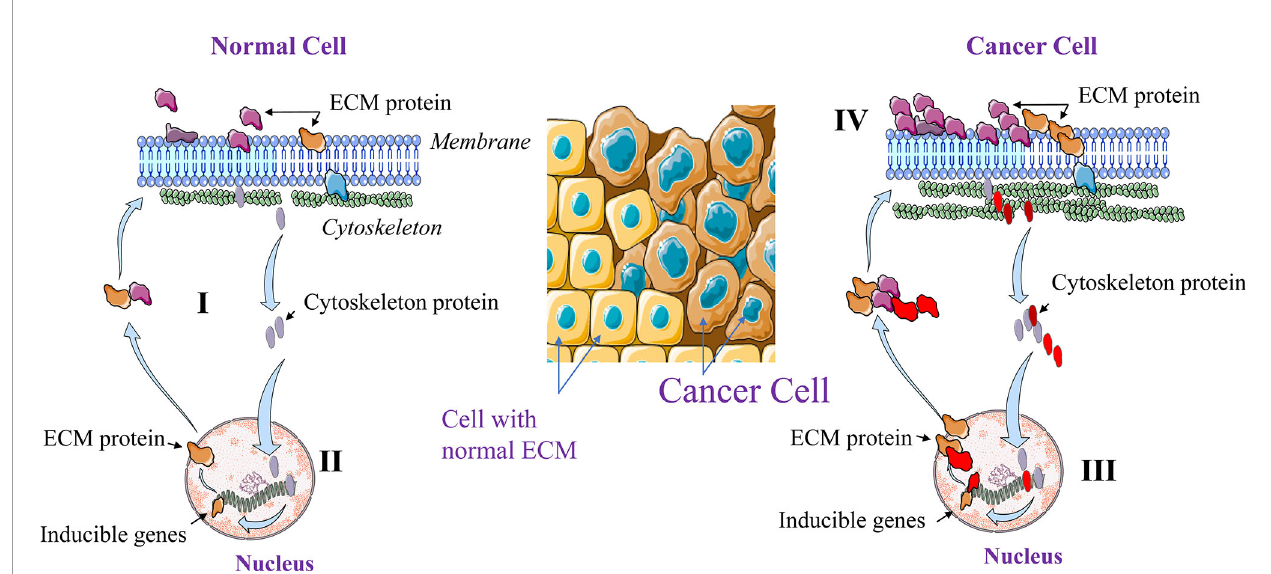
FIGURE 1 | Dynamic Reciprocating Model (DRM). At the normal single cell level, the cytoskeleton and the nuclear matrix interact in a reciprocal manner (I). This interaction maintains normal cellular architecture and functions through ECM components expression and remolding. Activated cytoskeleton molecules mediate the activation of various nuclear promotors that in turn induce the expression of molecules including ECM components that control the cellular shape and structure (II). In cancer cells this regulation is altered leading to high cytoskeleton and ECM components expression (III) and activation